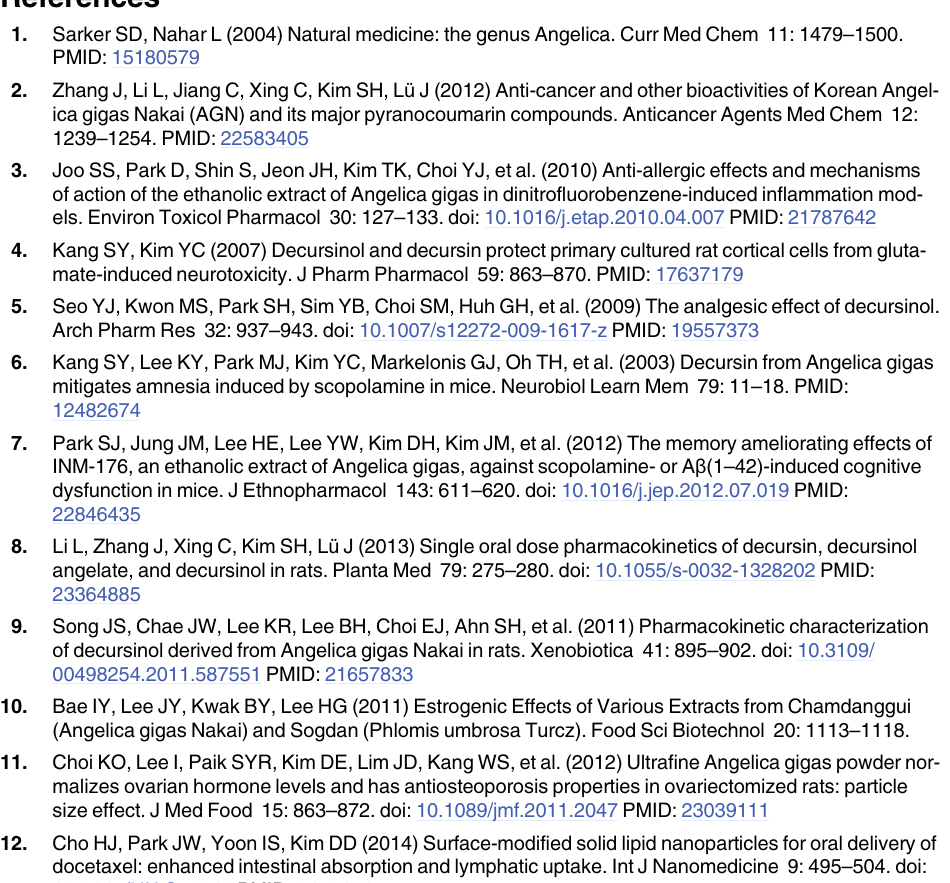
S2 Fig. SEM images of surface morphology of AGN formulations (F5 and F8). The length of scale bar in the image was 1 μ m. (TIF) S3 Fig. The contents (%) of D and DA in AGN EtOH ext after incubation 6 h at different temperature (20, 60, and 100°C). The percentage of content, compared to that value of AGN EtOH ext stored at -20°C, was presented. Data represent means ± SD (n = 3). (TIF) S1 Materials and Methods.